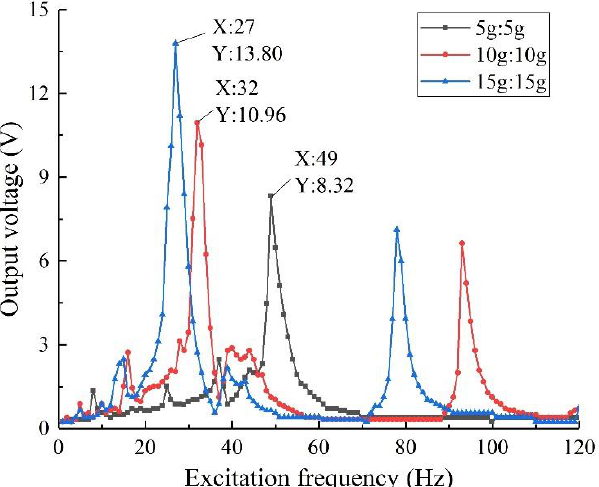
Figure 17. Output voltage with different mass ratios ( h 1 = 0.3 mm).